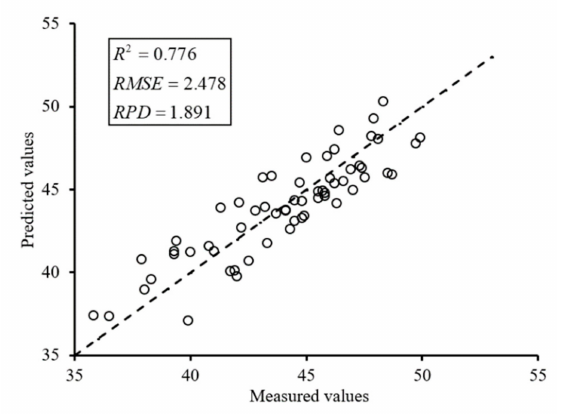
Figure 14. Testing result of developed detection